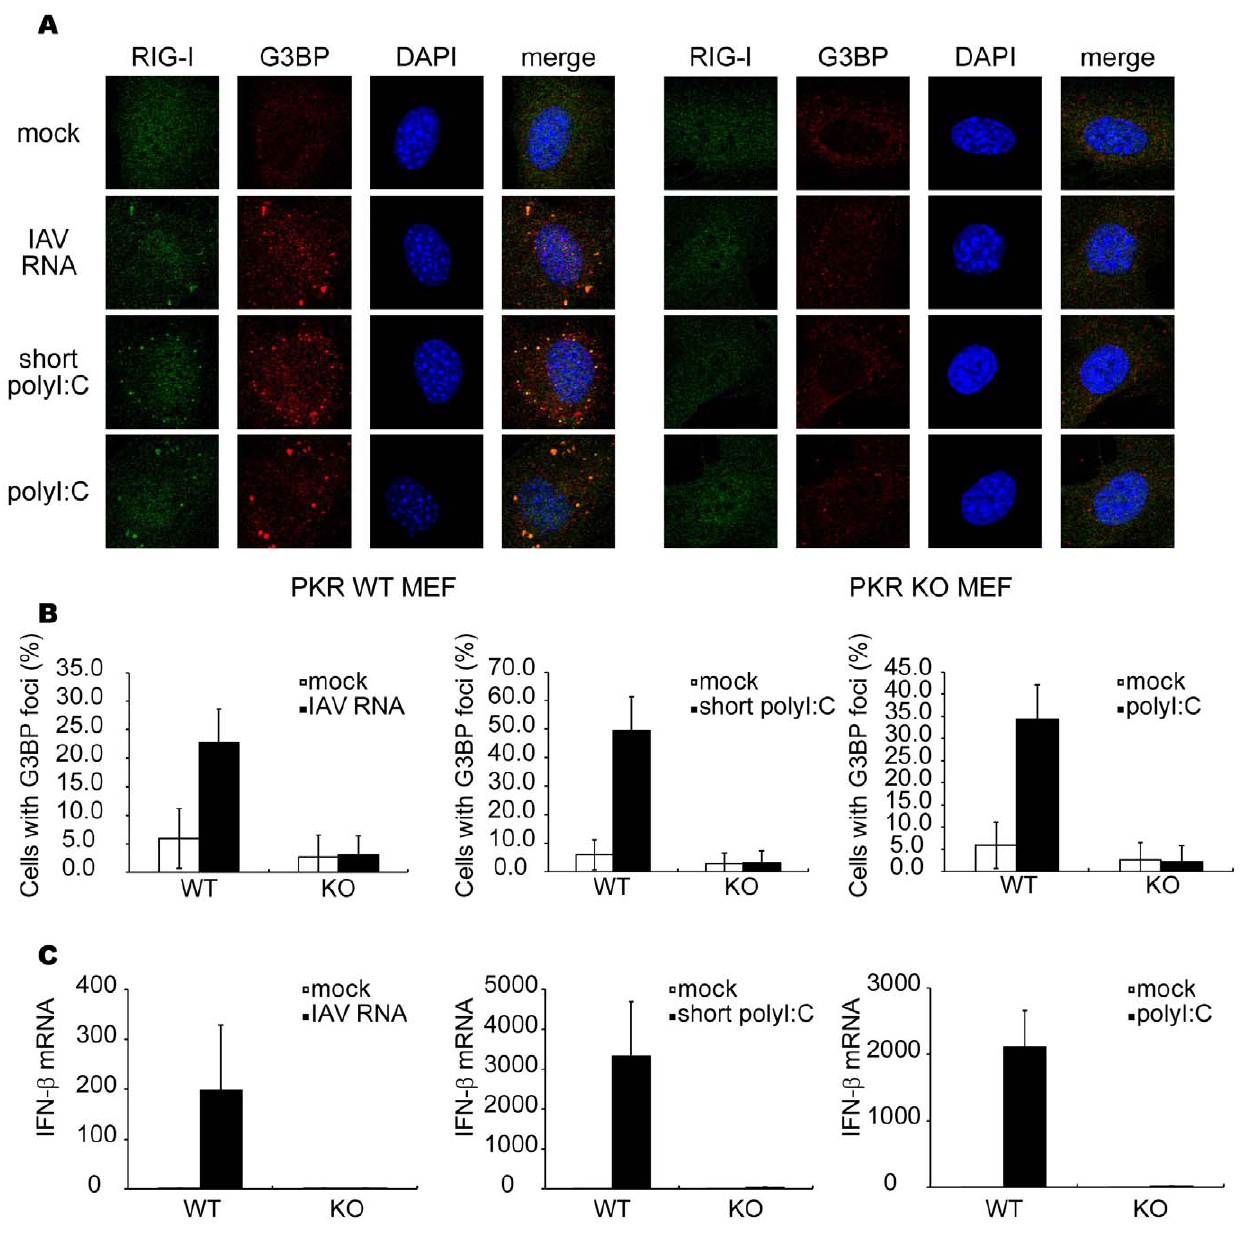
Figure 8. Viral RNA and polyI:C induce formation of avSGs and IFN-aˆ gene expression in a PKR-dependent manner. ( A–C ) MEFs derived from WT and PKR KO mice were mock-treated or transfected with IAV genomic RNA, short poly I:C or long poly I:C for 9 h and stained with anti-RIG-I, anti-G3BP antibodies and DAPI ( A ). The percentage of cells containing foci of G3BP was shown in ( B ). Relative IFN-aˆ mRNA levels were determined by qPCR ( C ). Data shown in B and C are represented as the mean standard 6 error of the mean